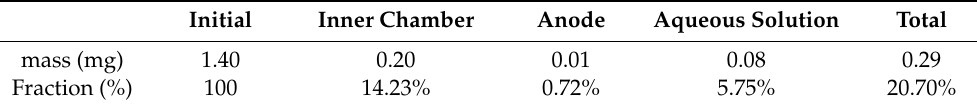
Table 2. The distribution of adsorbed TCS in the MFC with bioanode.